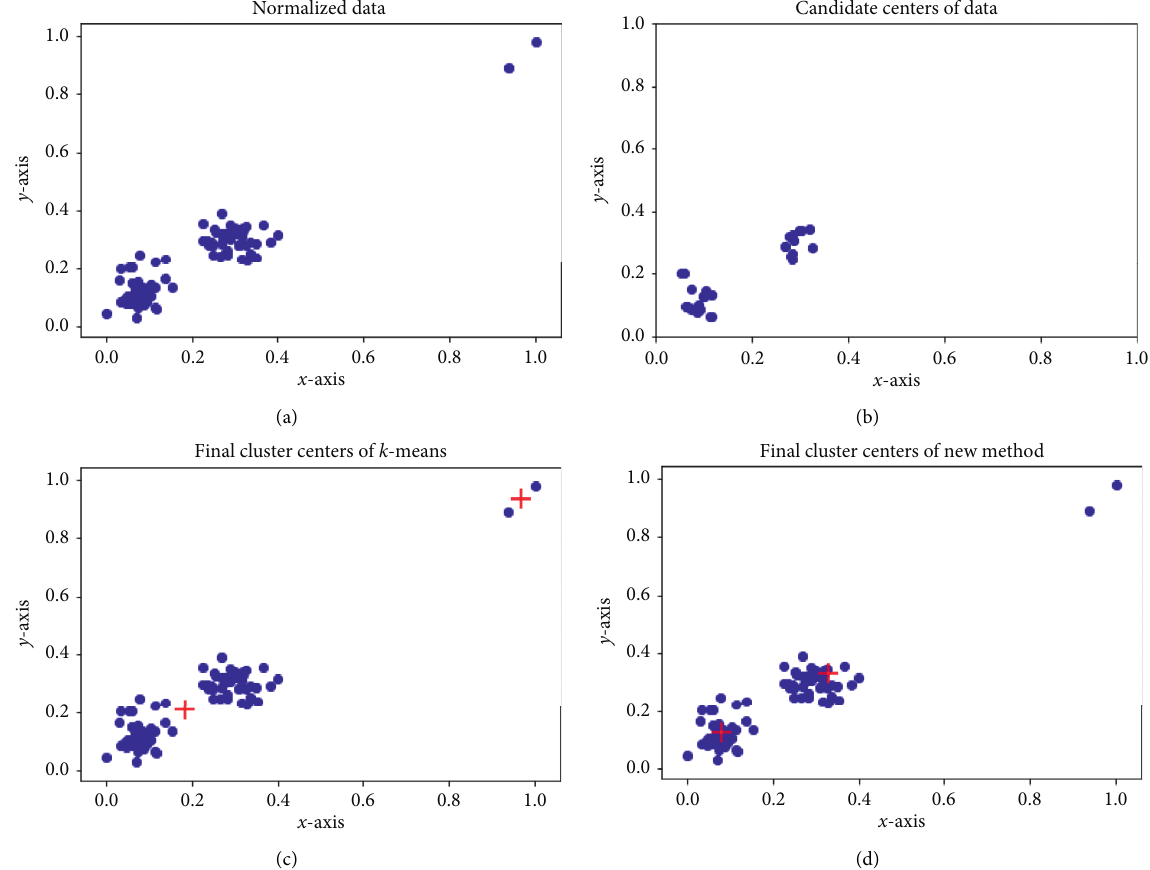
Figure 1: Experimental results on synthetic data set #1 (the red ‘+’s are the cluster centers). (a) Normalized data. (b) Selected subset. (c) Clustering centers of k -means algorithm. (d) Clustering centers of our proposed